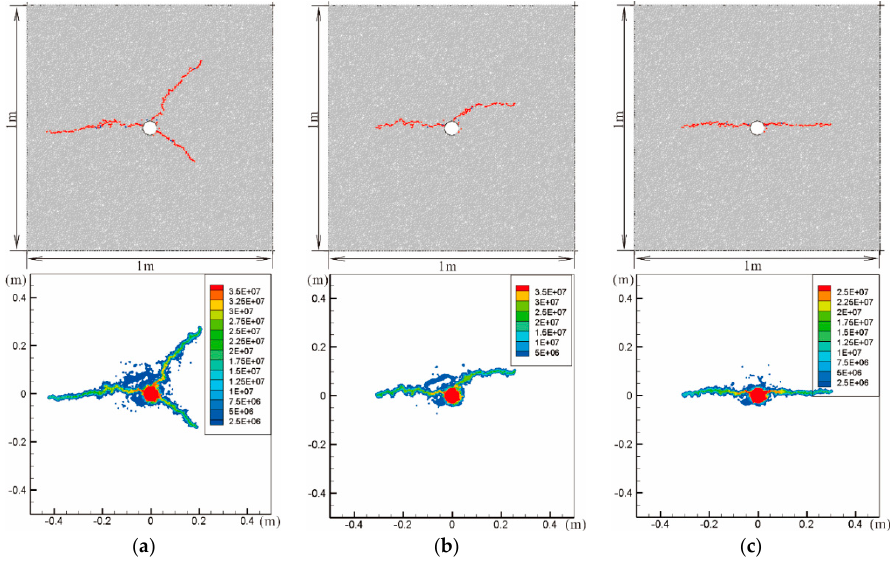
Figure 10. Crack distribution with corresponding pore ‐ pressure field under the injection rate of 1.0 × 10 − 4 m 3 /s: ( a ) S H : S h = 20:20; ( b ) S H : S h = 20:15; and ( c ) S H : S h = 20:12.